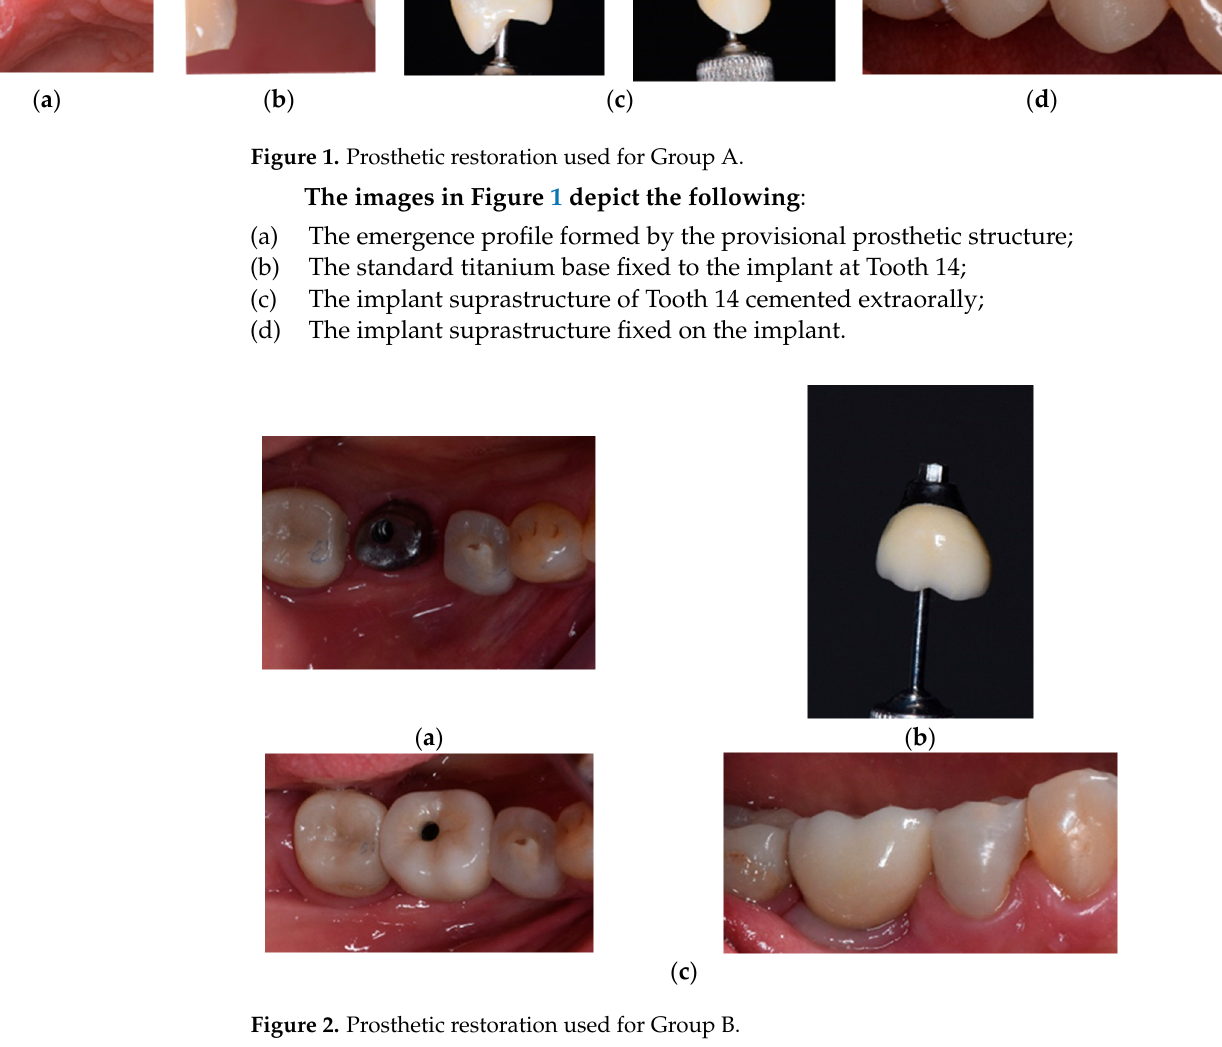
The implant suprastructure fixed on the implant—occlusal and vestibular view.